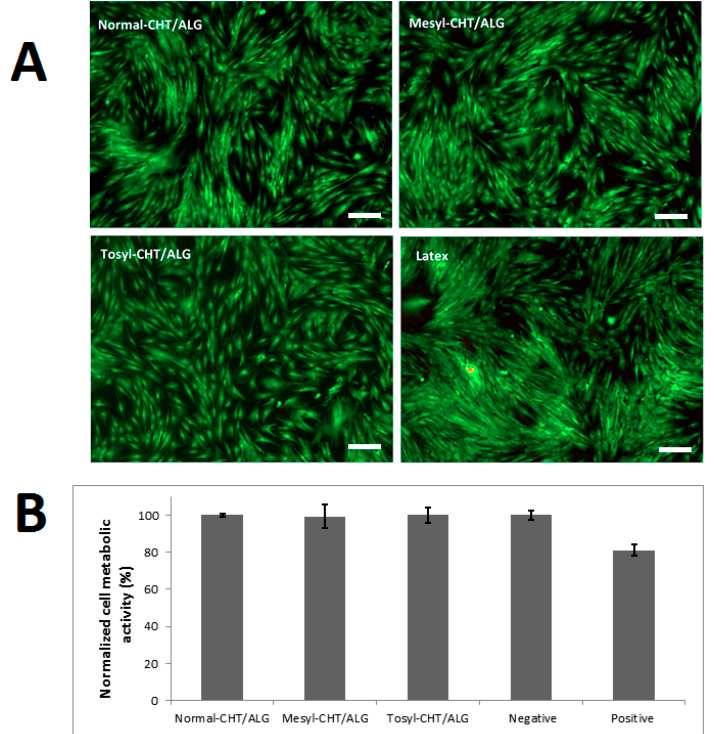
Figure 3. Representative fluorescence images of live (green) and dead (red) hASCs cultured on 24-well plates with the extract of mesyl–CHT/ALG, tosyl–CHT/ALG and normal–CHT/ALG multilayered films and latex. ( A ) (Scale bar = 200 µ m); Normalized metabolic activity of hASCs was measured in contact with the extract of CHT/ALG multilayered films as well as negative (24-well plate) and positive (Latex) controls ( B ). Results are presented as average ± SD.